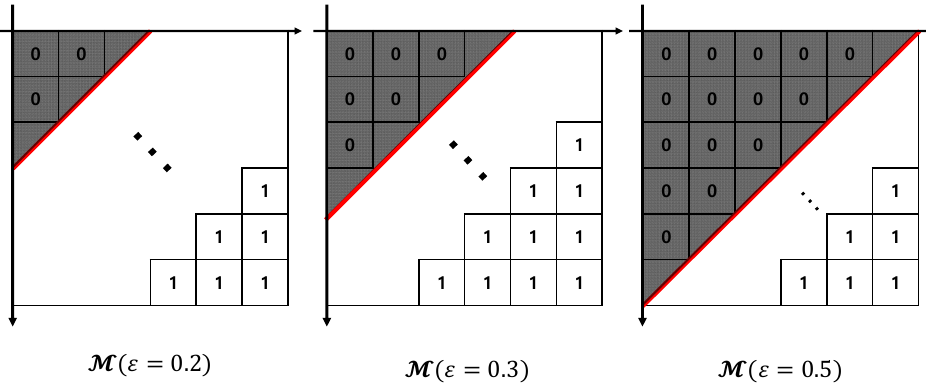
Figure 4. Examples of M according to ε . Because of the larger hyper-parameter ε , more low-frequency components are masked. We empirically set ε to 0.2.